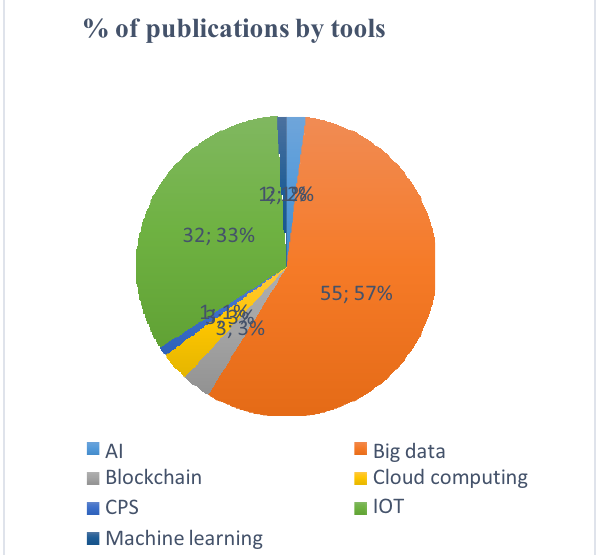
Fig 6. Distribution of publications by